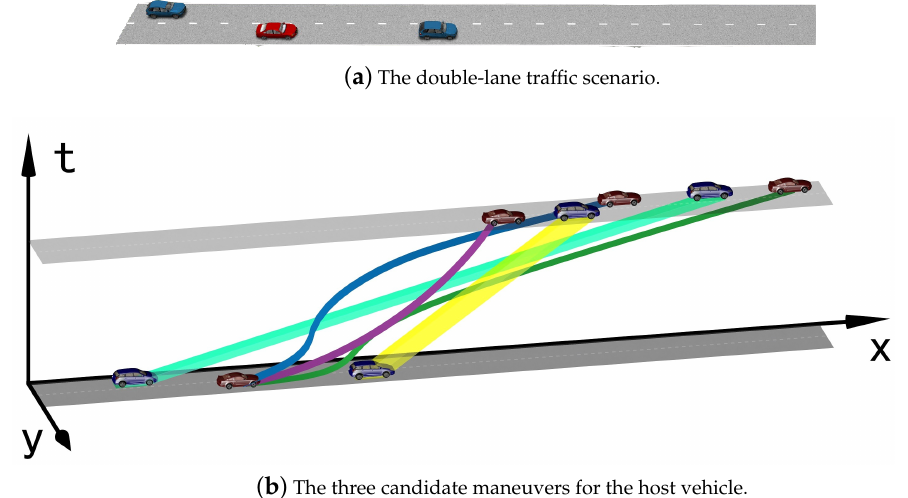
Figure 2. The candidate driving maneuvers in the double-lane traffic